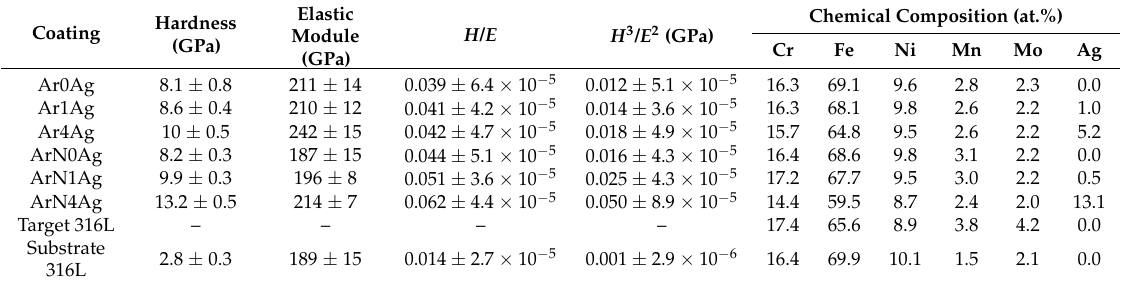
Table 3. Mechanical properties and chemical composition of deposited coatings.